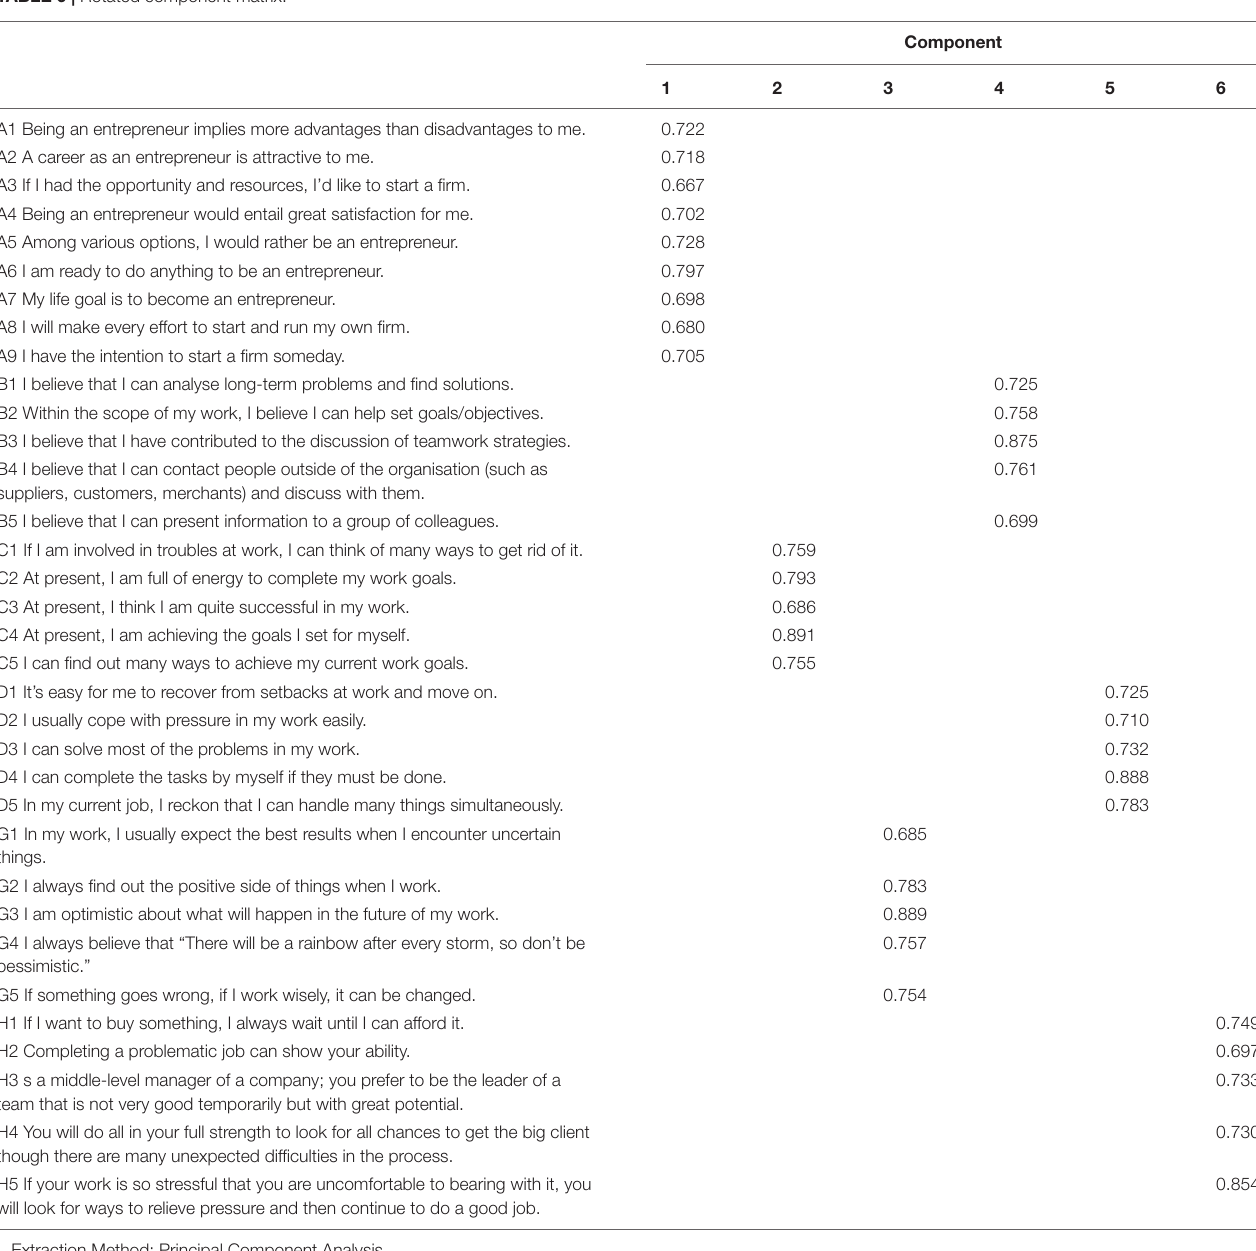
TABLE 6 | Rotated component